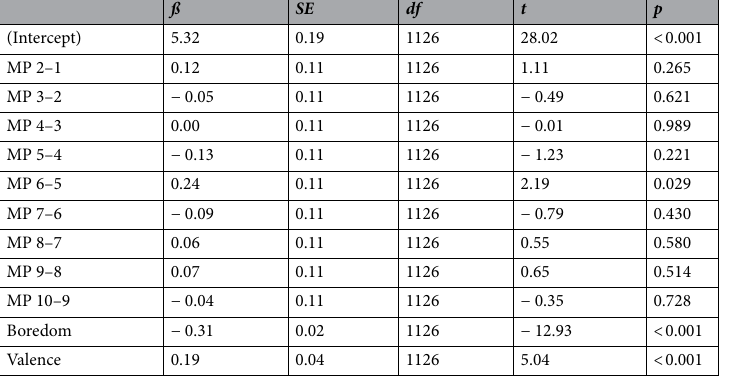
Table 4. Estimated fixed-effects parameters of the regression model (model 3) best and most economically predicting the pandemic PPT. The model included the predictors measurement point (MP), boredom and valence. Shown are effect estimates ( β ), standard errors (SE), degrees of freedom (df), t and p values. The difference coding compares the means of two consecutive measurement